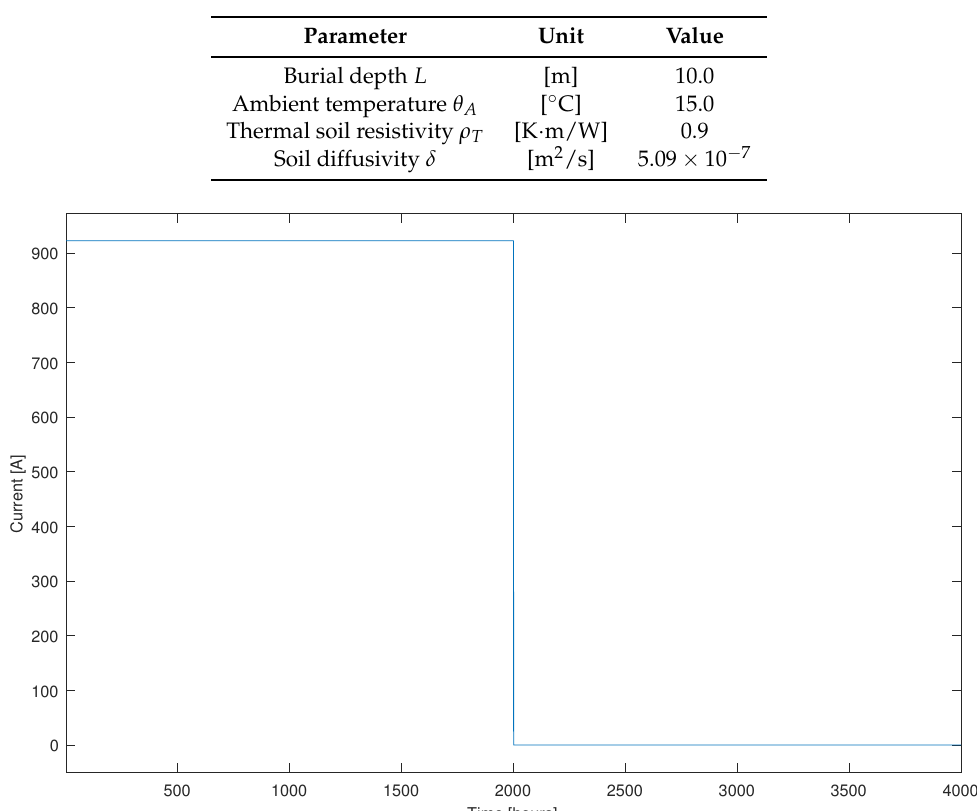
Table A2. Surrounding conditions for COMSOL Multiphysics FEM validation of an estimated 220 [kV] 3 × 1800 [mm 2 ] Al XLPE SL-type submarine cable.